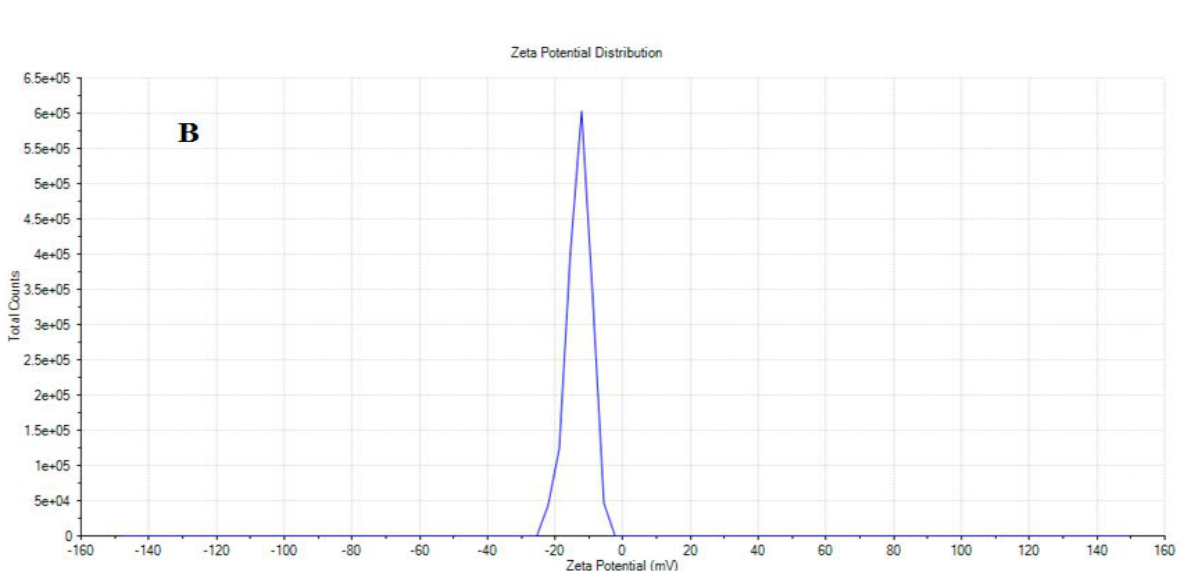
Figure 3. Zeta potential of β -Nb2ZnO6 nanoparticles ( A and B ).